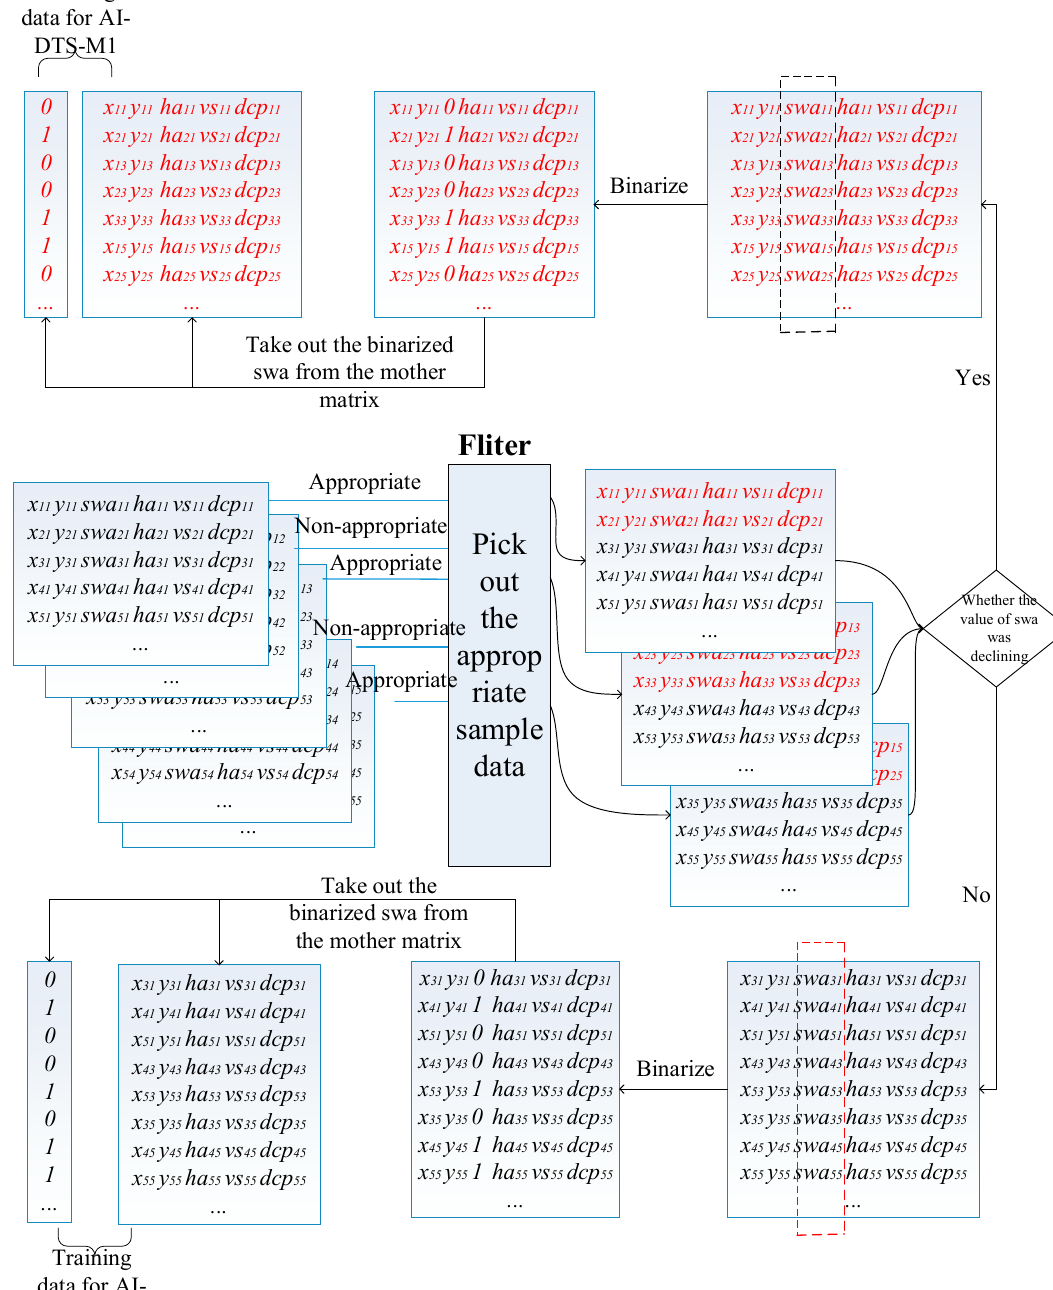
Figure 13. The process of sample data preprocessing.